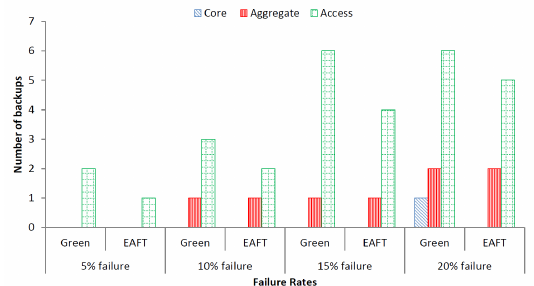
Figure 4. Three-tier random device failure